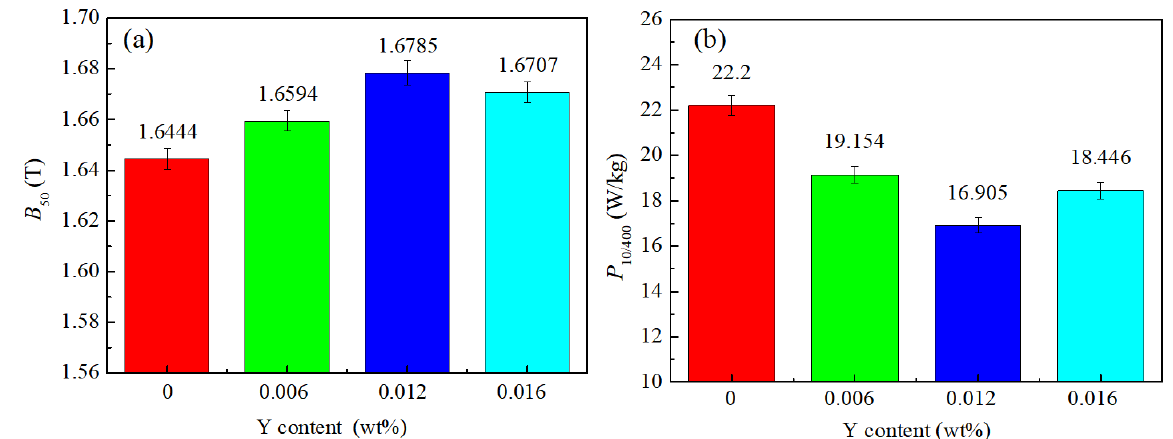
Figure 1. Magnetic properties of final sheets with different Y contents: ( a ) B 50 and ( b ) P 10/400 .